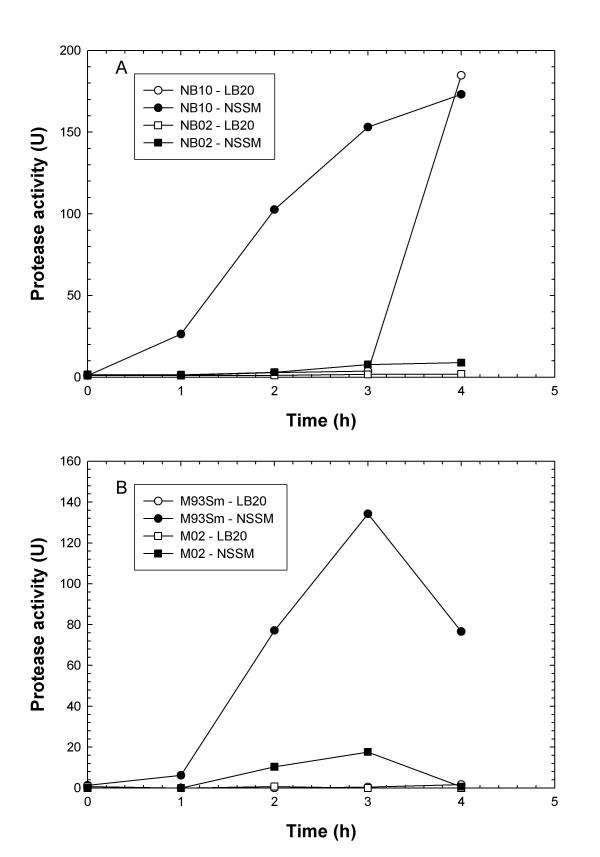
Induction of protease activity in V. anguillarum wild type (circles) and vanT mutant strains (squares). Cells were grown for 16 h in LB20, harvested by centrifugation, washed twice in NSS, and resuspended at 2 × 109 CFU/ml in either LB20 (open symbols) or NSSM (solid symbols). (A) NB10 and vanT mutant, NB02. (B) M93Sm and vanT mutant, M02. Both of the experiments shown represent a single experiment, although each experiment was repeated at least three times with similar results.